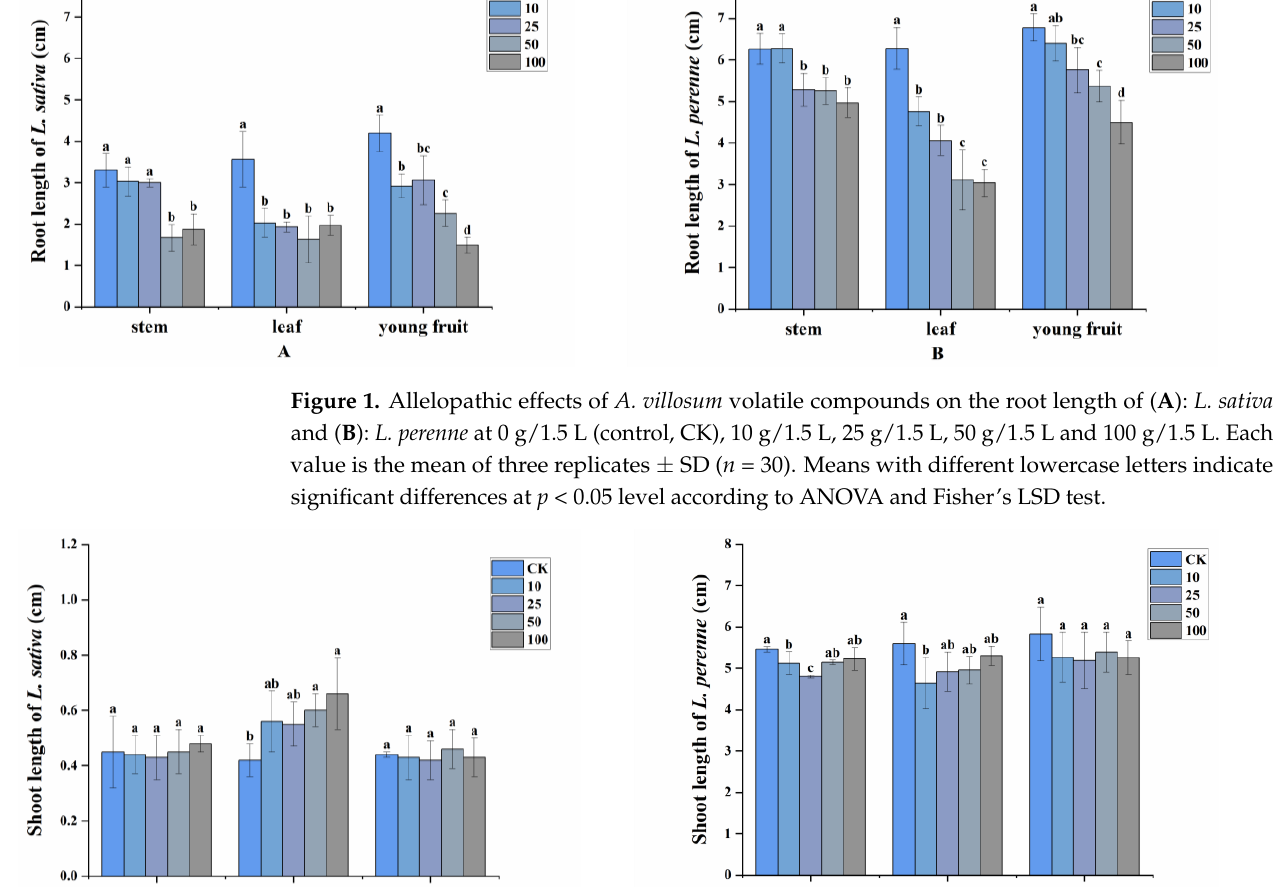
Figure 2. Allelopathic effects of A. villosum volatile compounds on the shoot length of ( A ): L. sativa and ( B ): L. perenne at 0 g/1.5 L (control, CK), 10 g/1.5 L, 25 g/1.5 L, 50 g/1.5 L and 100 g/1.5 L. Each value is the mean of three replicates ± SD ( n = 30). Means with different lowercase letters indicate significant differences at the p < 0.05 level according to ANOVA and Fisher’s LSD